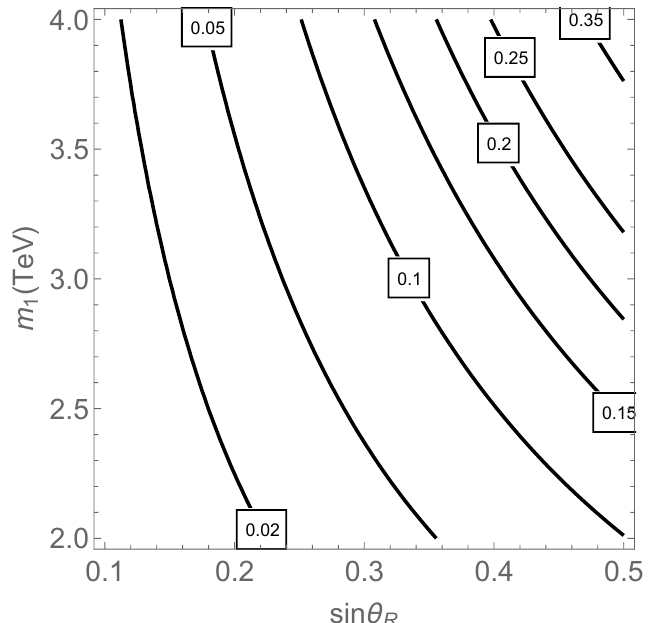
Figure 1 . Contour lines of ( V y ) 23 in the plane (sin (cid:18) R ; m 1 ) as (cid:12)xed from the best (cid:12)t value to the u R experimental data for R ( (cid:3) ) D